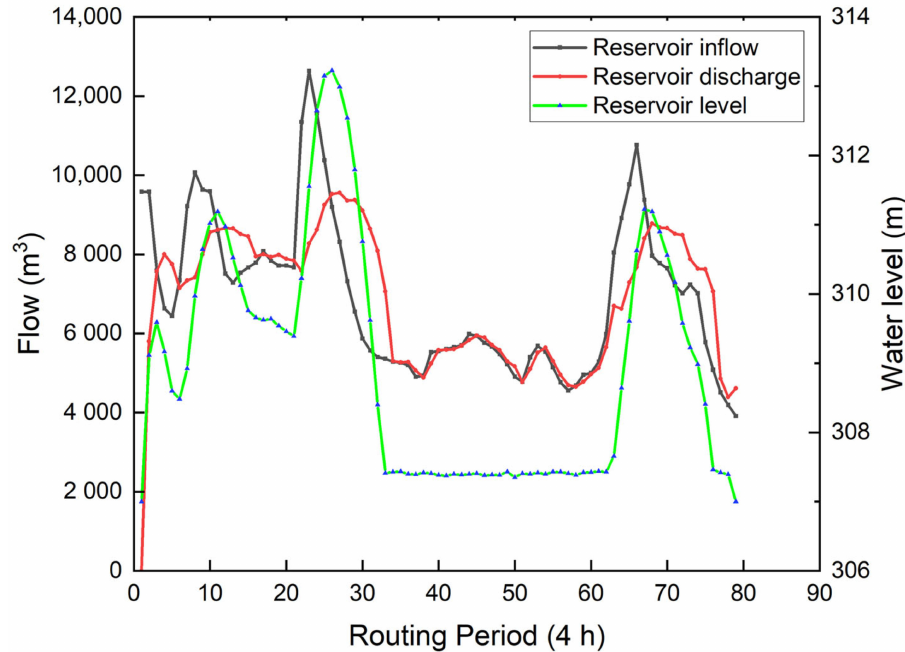
Figure 6. Sanmenxia Reservoir operation